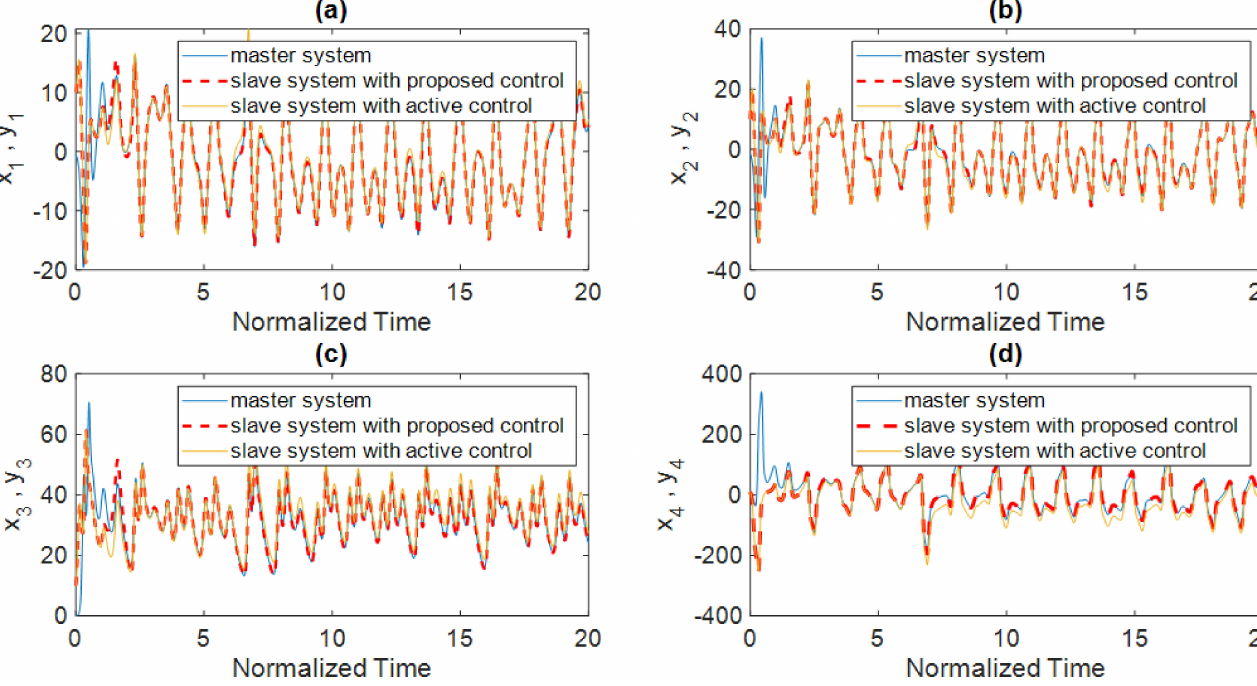
Figure 8. Synchronization results based on the proposed control methodology and active control, where there are both bias faults and partial loss of effectiveness. Time history of states ( a ) x 1 and y 1 , ( b ) x 2 and y 2 , ( c ) x 3 and y 3 , ( d ) x 4 and y 4